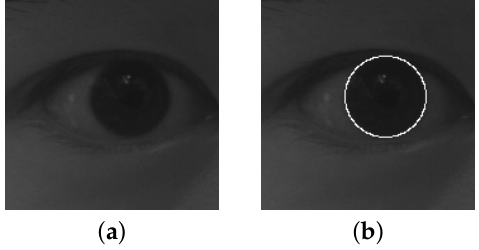
Figure 2. Eye-containing image processed using Daugman operator: ( a ) original image; ( b ) processed